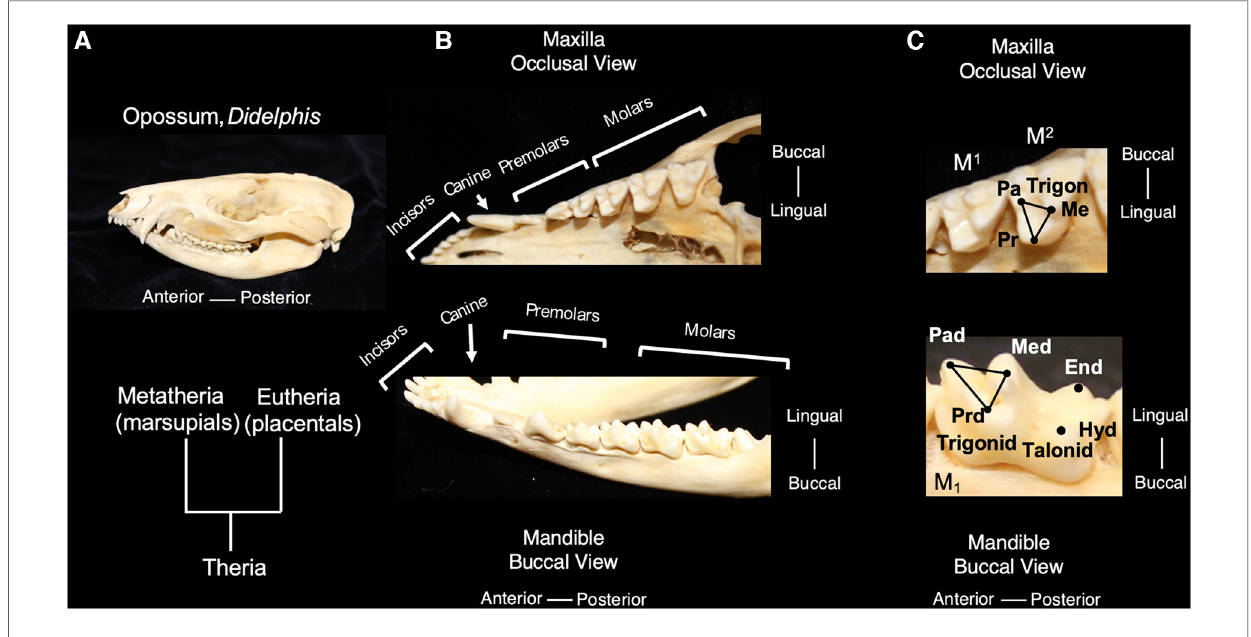
FIGURE 1 The tribosphenic molar shape is present in advanced therian mammals, the common ancestor to metatherian and eutherian mammals; molars of the opossum, Didelphis virginianus , are representative of this primitive tooth shape ( A ). An occlusal view of the maxilla and buccal view of the mandible show the tooth classes present in Didelphis ( B ). The trigon in the maxillary molars of Didelphis includes the tooth cusps of paracone (pa) metacone (me) and protocone (pr) and is highlighted with black lines. The trigonid in the mandibular molars includes the tooth cusps of paraconid (pad), metaconid (med) and protoconid (prd) and is highlighted with black lines. The talonid is the region posterior of the trigonid and includes the posterior cusps, hypoconid (hyd) and entoconid. ( C ) Teeth are not shown to